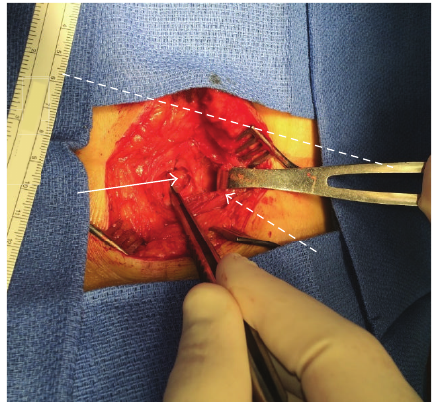
Figure 2: Defect following reduction of patient’s hernia. Dashed line: approximate location of right 12th rib. Dashed arrow: anterolat- erally retracted latissimus dorsi. Solid arrow: adipose tissue reduced through